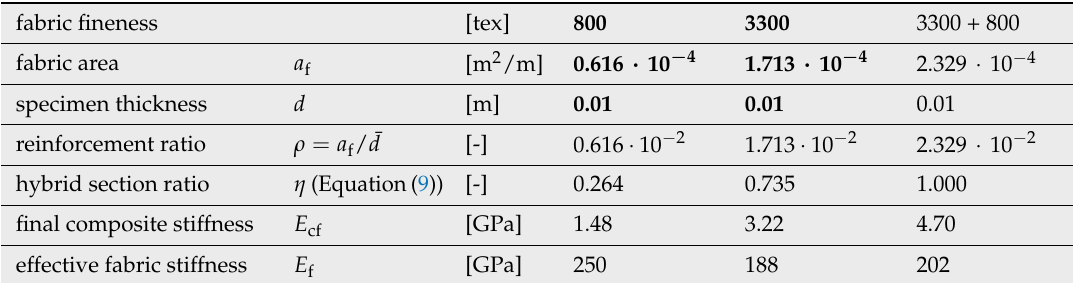
Figure 8. Tensile response of the cross sections with ( a ) 800 tex, ( b ) 3300+tex reinforcement and ( c ) of the hybrid cross section 3300+800 tex. Table 1. Cross section characteristics; parameters of performed tests in boldface font, derived values in normal